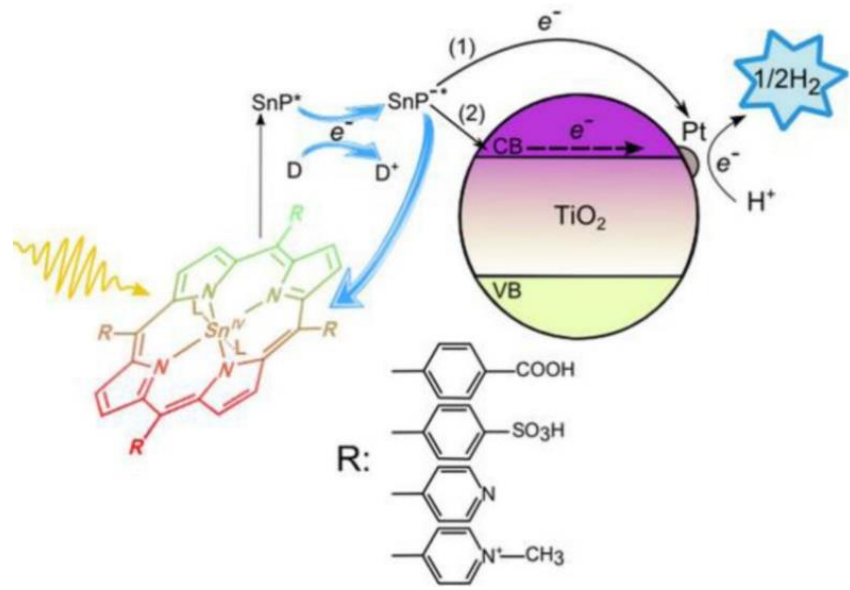
Figure 26. Schematic representation of the photoexcitation and electron transfer processes for hydrogen evolution under visible light irradiation in the presence of Sn(IV) porphyrins/Pt-TiO 2 nanocomposites. Reproduced from reference [94] with permission from the American Chemical Society, copyright 2016.